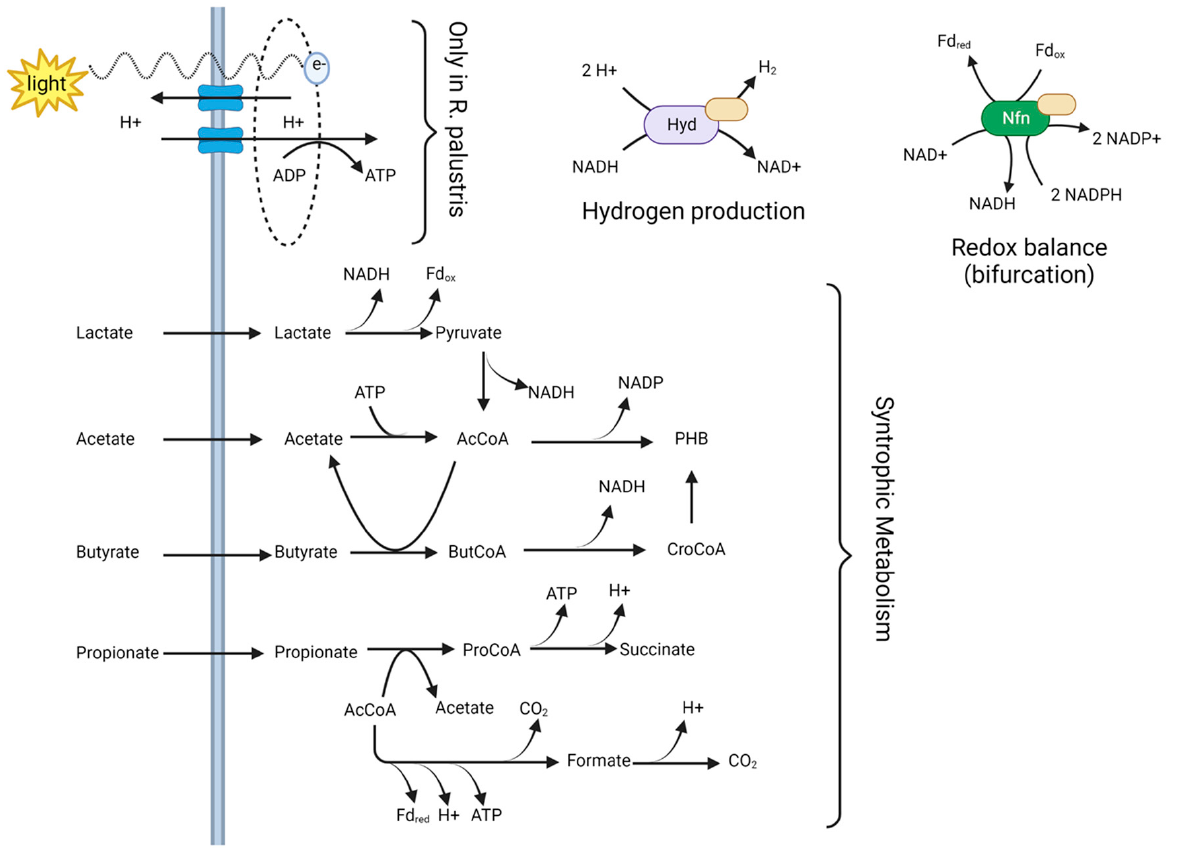
Figure 4. Proposed metabolic mechanisms involved in bioH 2 and PHB production in mixed cultures bioaugmented with S. wolfei . Acetyl CoA, AcCoA. Butiryl CoA, ButCoA. Propionyl Co A, ProCoA. Crotonyl CoA, CroCoA. Reduced ferredoxin, Fd red . Oxidised ferredoxin, Fd ox . Created with BioRender.com.